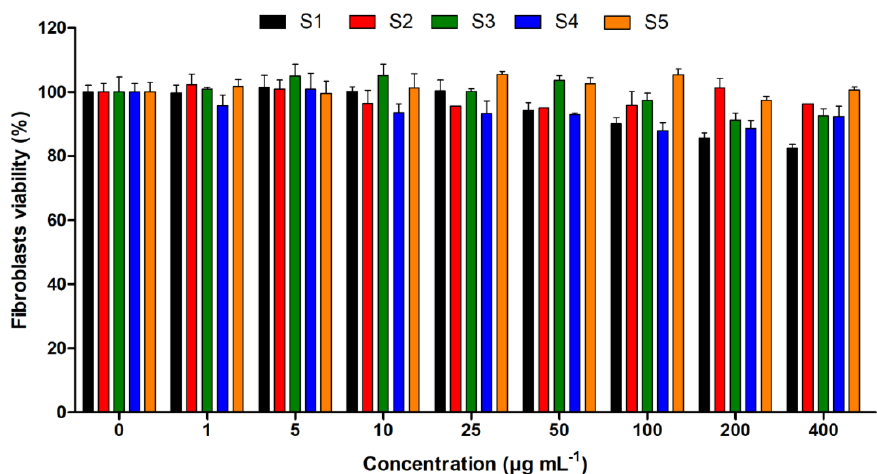
Figure 6. Cytotoxicity study of pure extract and MOE/SA/PVA on living human fibroblasts treated